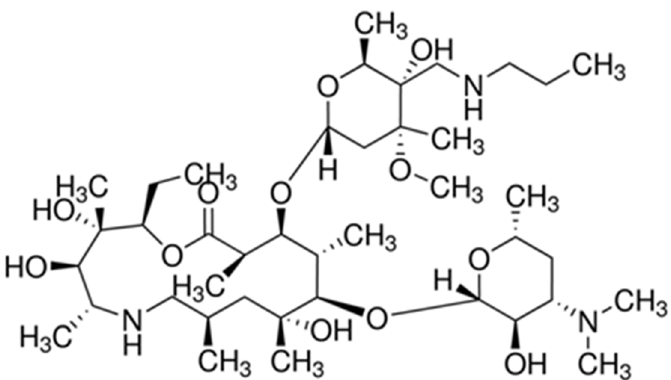
Figure 1. Chemical structure of tulathromycin.